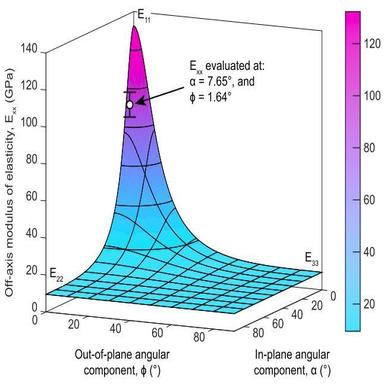
Estimation of the off-axis elasticity modulus as a function of the fibre waviness magnitude via Euler angle transformation.